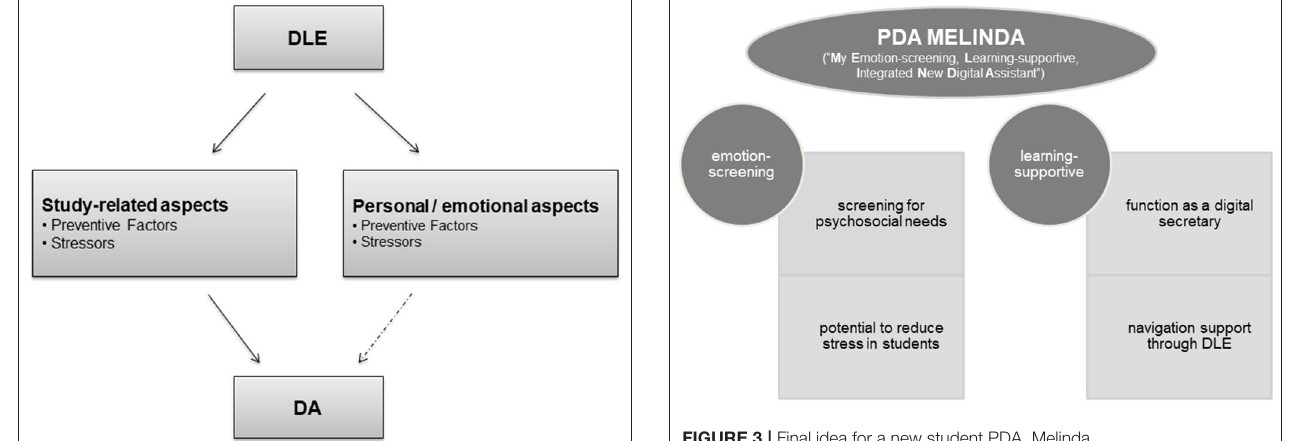
FIGURE 3 | Final idea for a new student PDA,